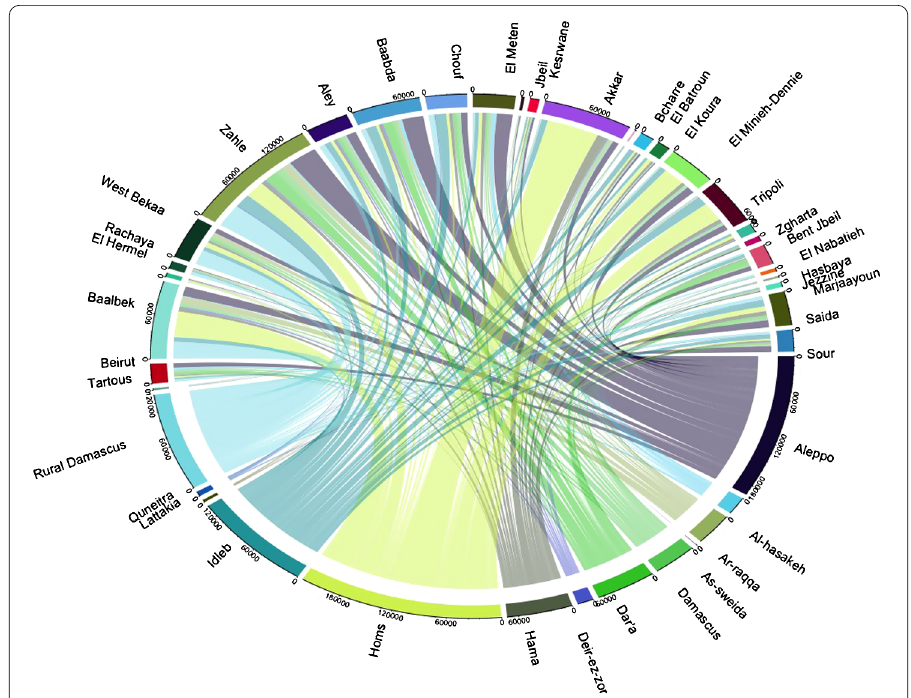
Figure 1 The chord diagram depicts the flow between Syrian districts and Lebanese